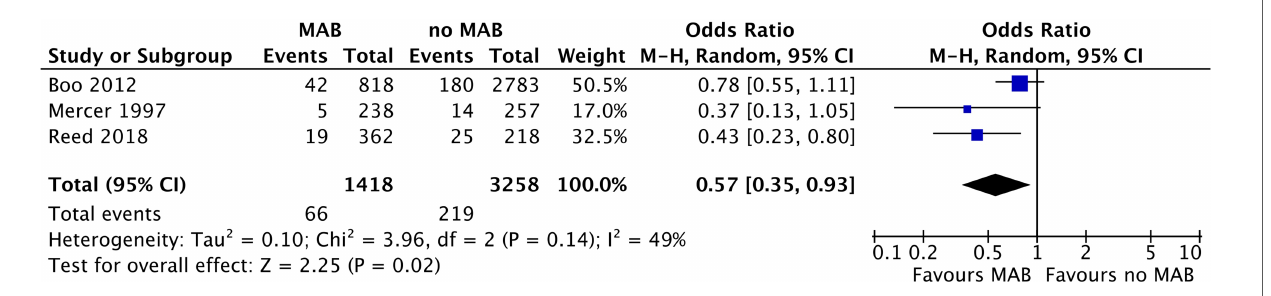
not be scored due to insuf fi cient information.